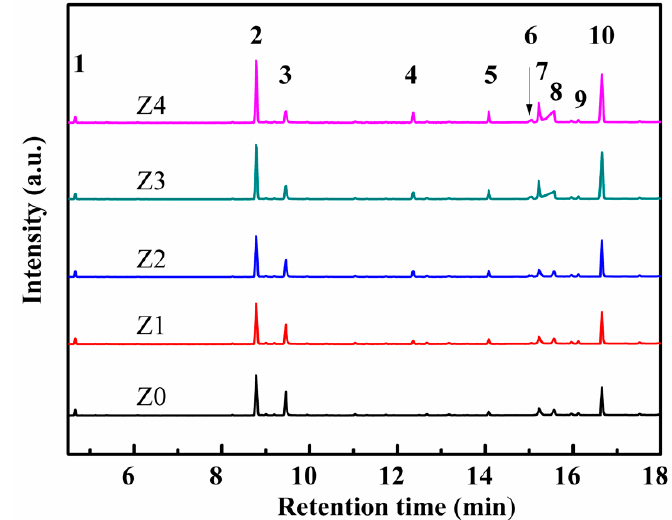
Figure 9. GC-MS spectrum of organic byproducts of toluene degradation over different catalysts by plasma catalysis: 1. n-octane, 2. benzaldehyde, 3. phenol, 4. benzyl formate, 5. o-nitrophenol, 6. o-nitrotoluene, 7. o-nitrobenzene methanol, 8. benzoic acid, 9. n-dodecane, 10.